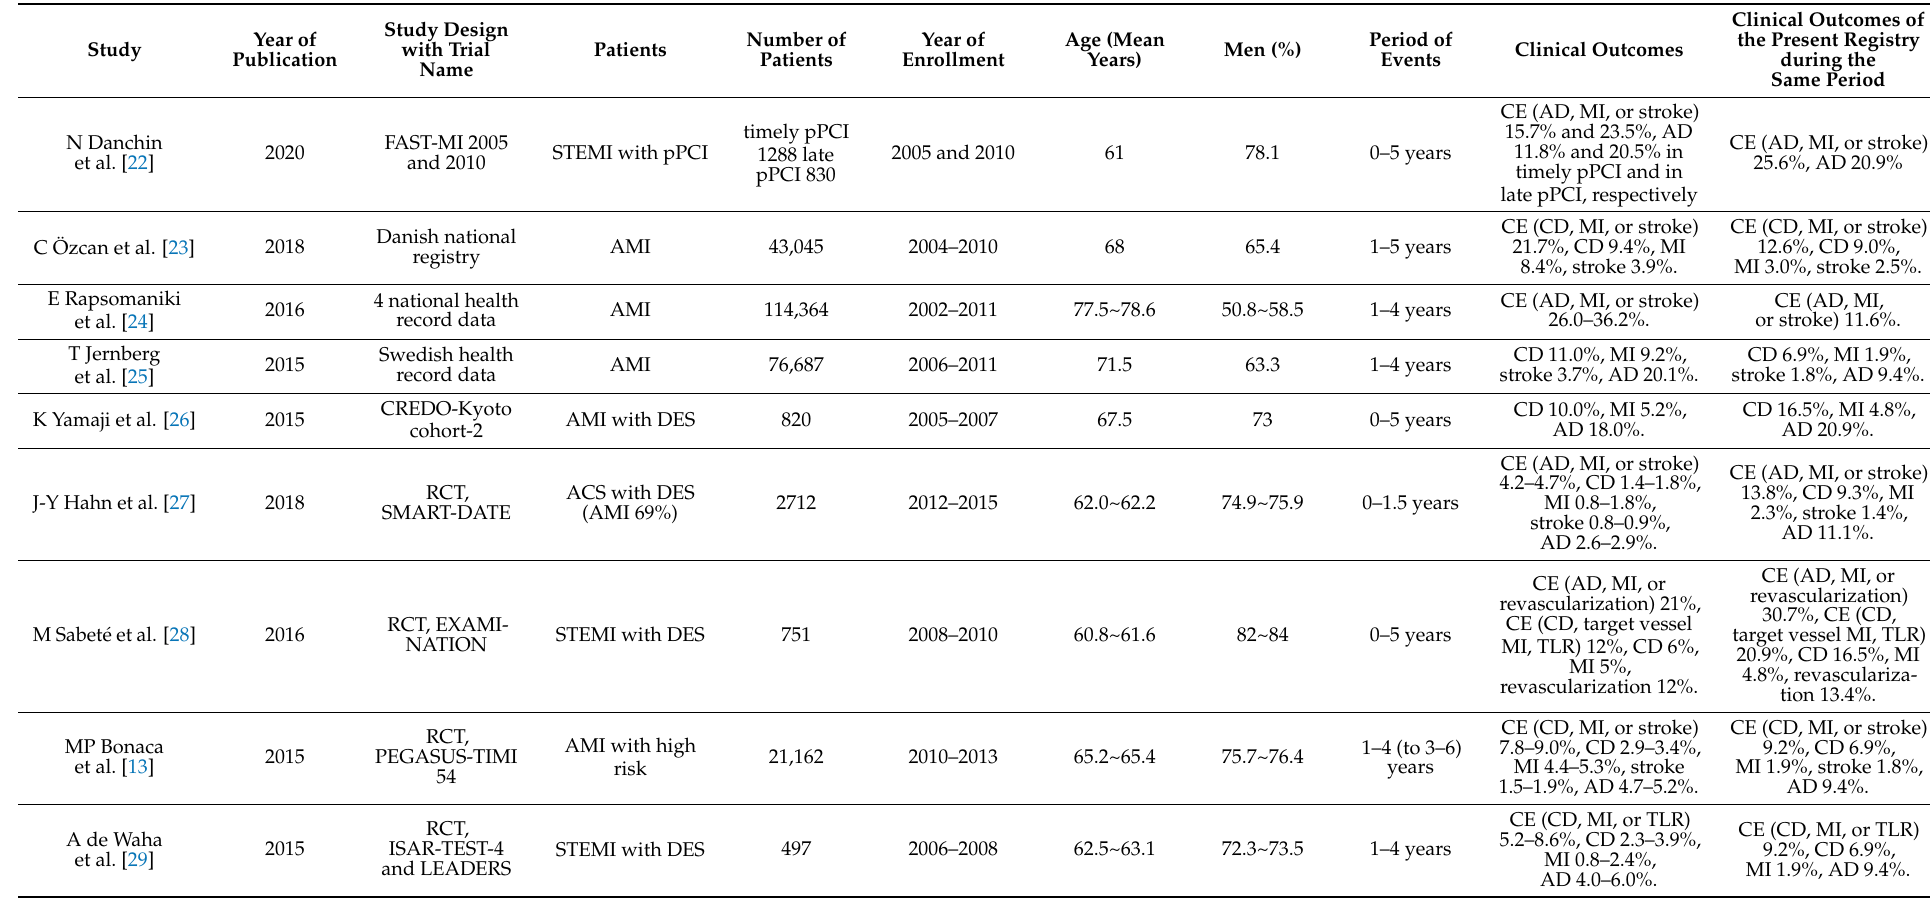
Table 5. Long-term clinical outcomes in representative registry studies and randomized controlled trials of patients with acute myocardial